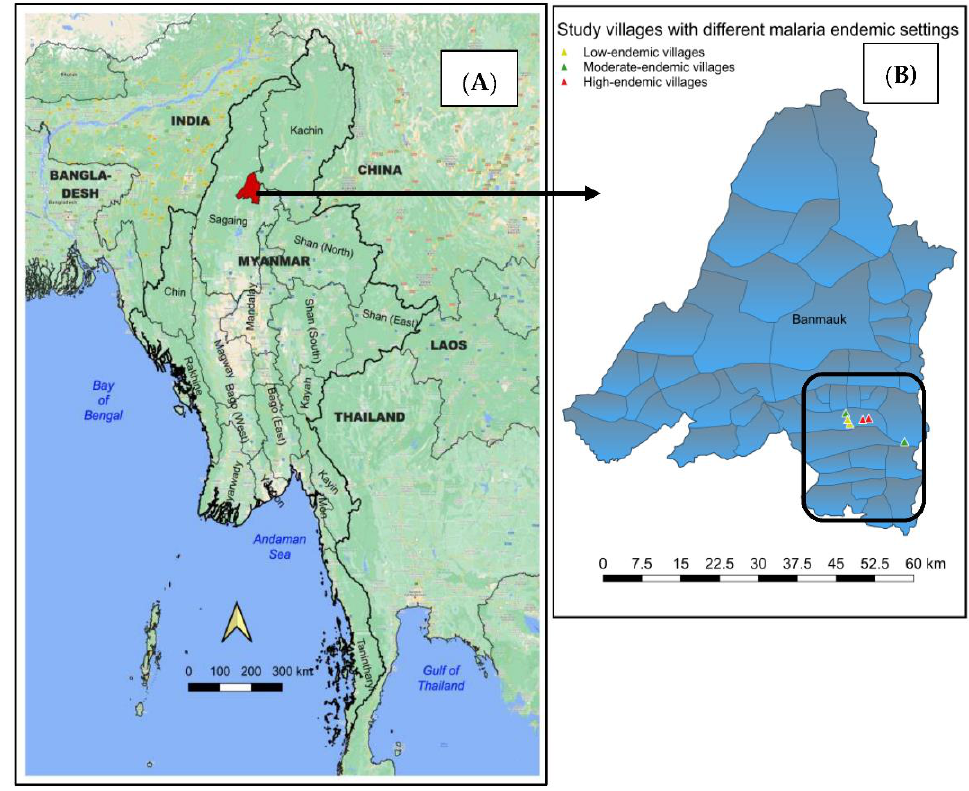
Figure 1. Locations of study township and villages. ( A ) Banmauk Township from the Sagaing Region of Northern Myanmar. ( B ) Six study villages with different malaria situations in a village tract from the township.